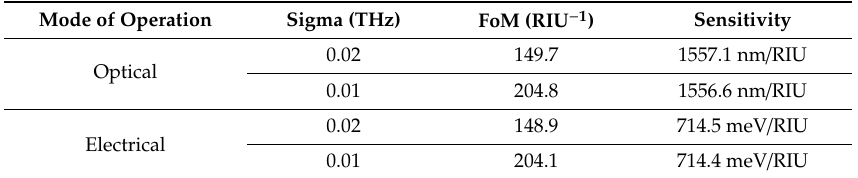
Table A1. Calculated sensitivity and FoM under the finite band